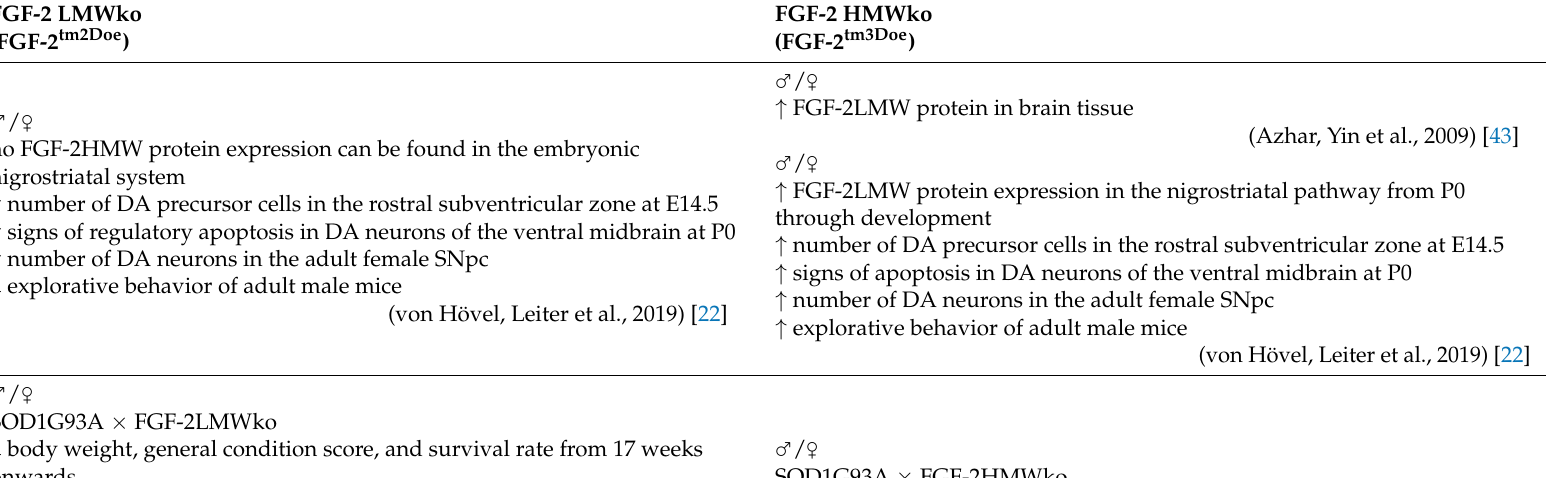
/ ♀ SOD1G93A × FGF-2HMWko ↑ performance in the rotarod test in weeks 17, 18, 19, 20 and 21